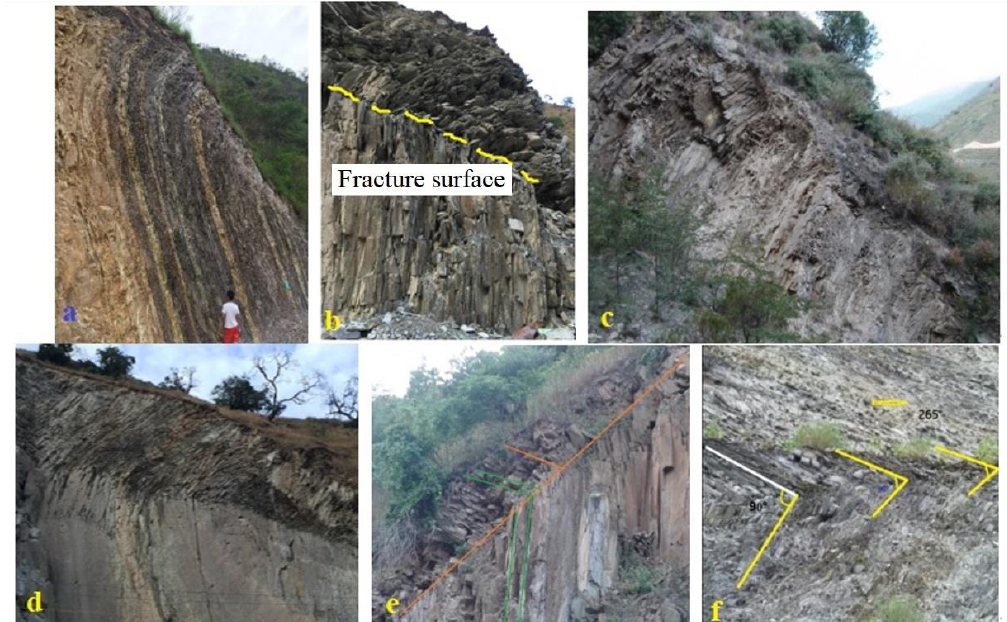
Figure 4. ( a ) Metasandstone toppling deformation at Qingcaiping on the left bank. ( b ) toppling shallow broken in metasandstone. ( c ) toppling broken face in consequent slope. ( d ) toppling broken face in reverse slope of metasandstone. ( e ) toppling bending in slate. ( f ) slate toppling deformation body at the crossing road downstream of Biaocun town on the right bank.